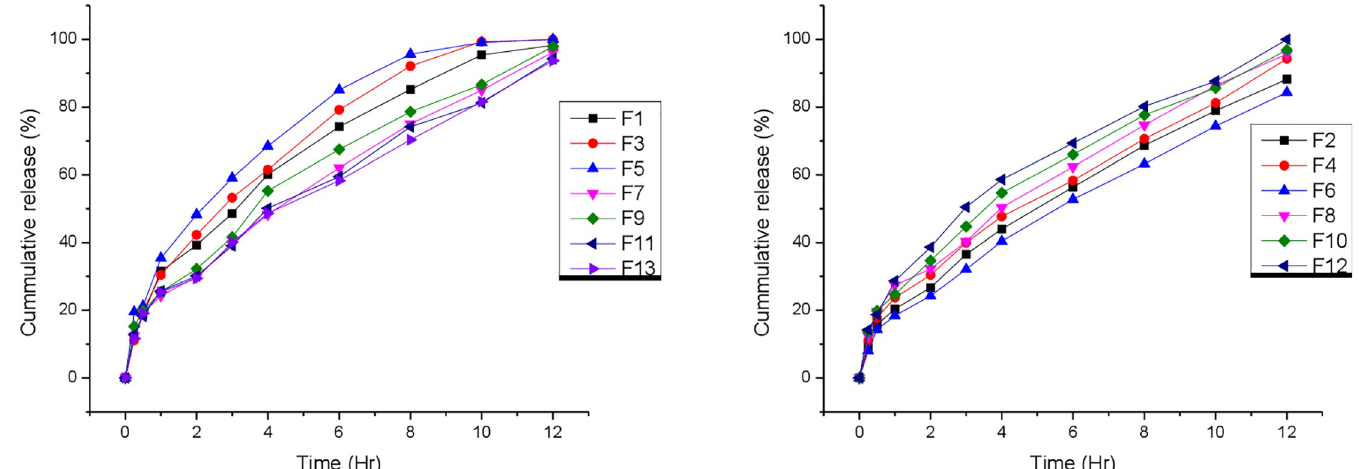
Fig 2. In vitro release profiles of the 13 formulations of ranitidine HCl (150 mg) matrix.